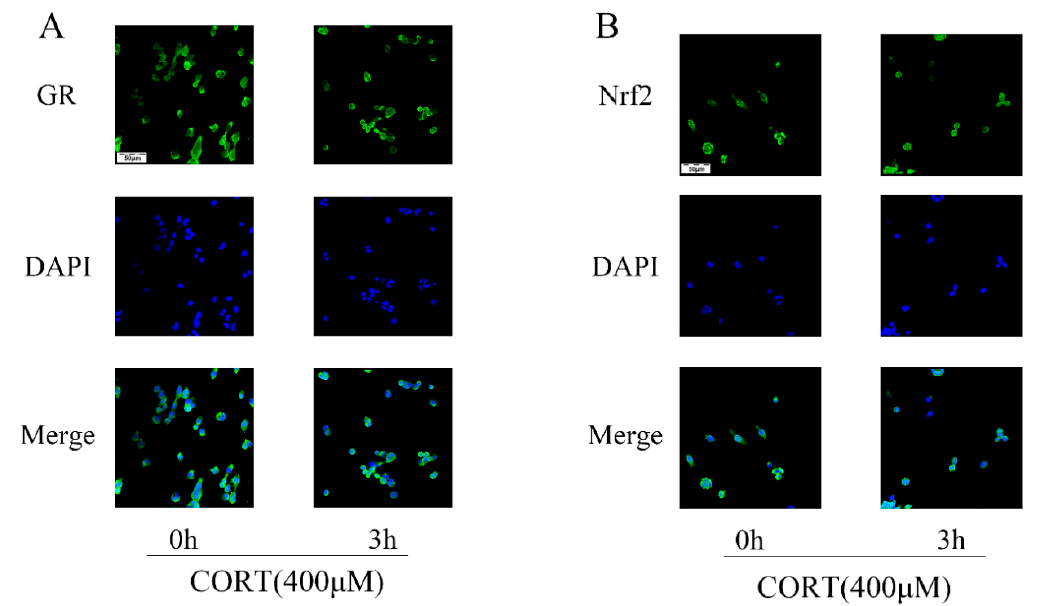
Figure 13. The GR ( A ) and Nrf2 ( B ) protein localizations were detected by immunofluorescence staining with or without cortisol (CORT) treatment for 3 h and viewed under a laser scanning confocal microscope.